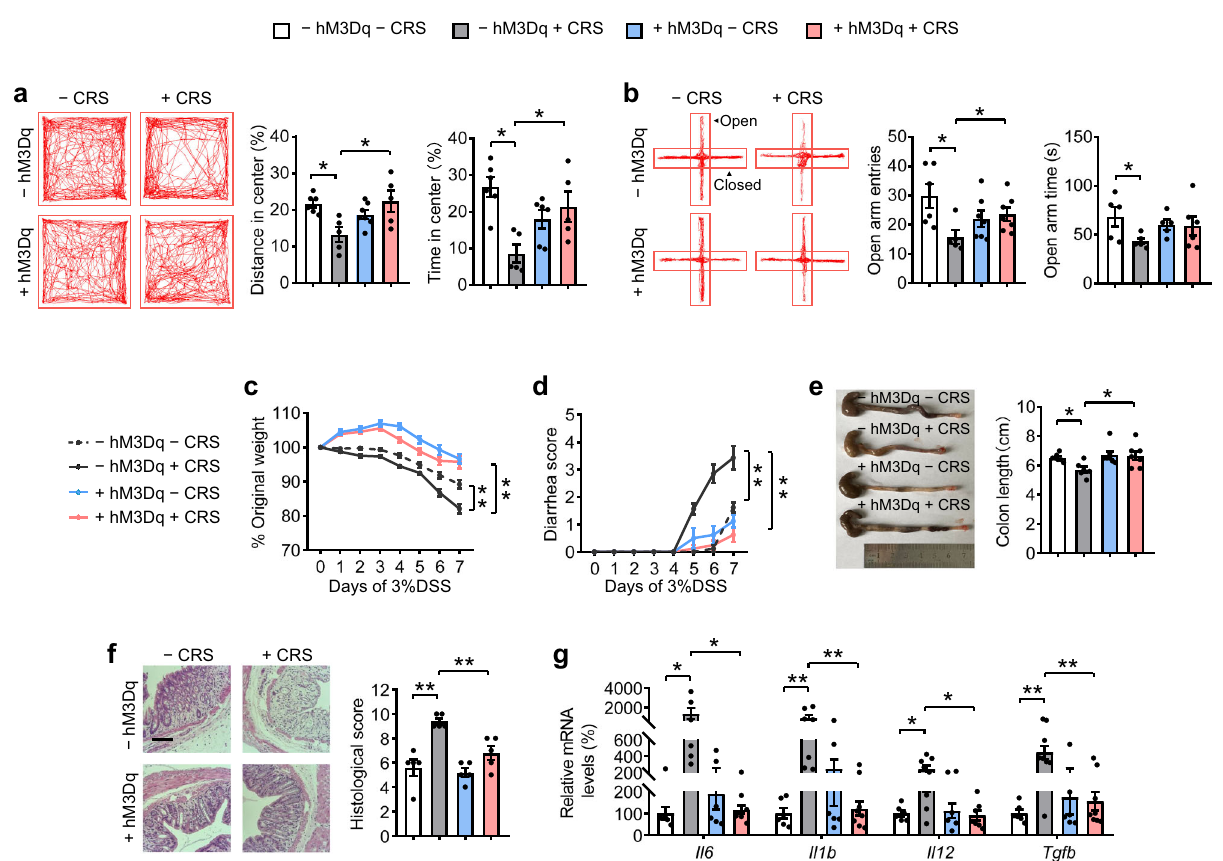
Fig. 1 Activation of AgRP neurons reverses CRS-induced anxiety behaviors and colitis. a Representative tracks and statistical results in OF test. b Representative tracks and statistics in EPM test. c Percentage of body weight loss. d Scores of diarrhea. e Gross morphology and length of the colon. f H&E staining and histological scores of the colon tissues. Scale bar, 110 μ m. g qRT-PCR analysis of mRNA expression of in fl ammatory cytokines ( Il6, Il1b, Il12 , and Tgfb ) in the distal colon tissues. Studies for a , b were conducted using 10 – 12-week-old AgRP-Cre mice receiving AAV expressing mCherry ( − hM3Dq) or hM3Dq ( + hM3Dq), all mice experienced unstressed ( − CRS) or stressed ( + CRS) treatment for 14 days. Behavioral tests were performed 30 min after single CNO injection on day 15 ( a ) and day 16 ( b ). c – g were performed using − hM3Dq mice and + hM3Dq mice under treatment of 3% DSS in drinking water for 7 days to induce acute colitis with ( + CRS) or without ( − CRS) stress, simultaneously receiving CNO injections every 12 h per day. Values are expressed as means ± SEM ( n = 5 – 8 per group), with individual data points. Data were analyzed using two-way analysis of variance, followed